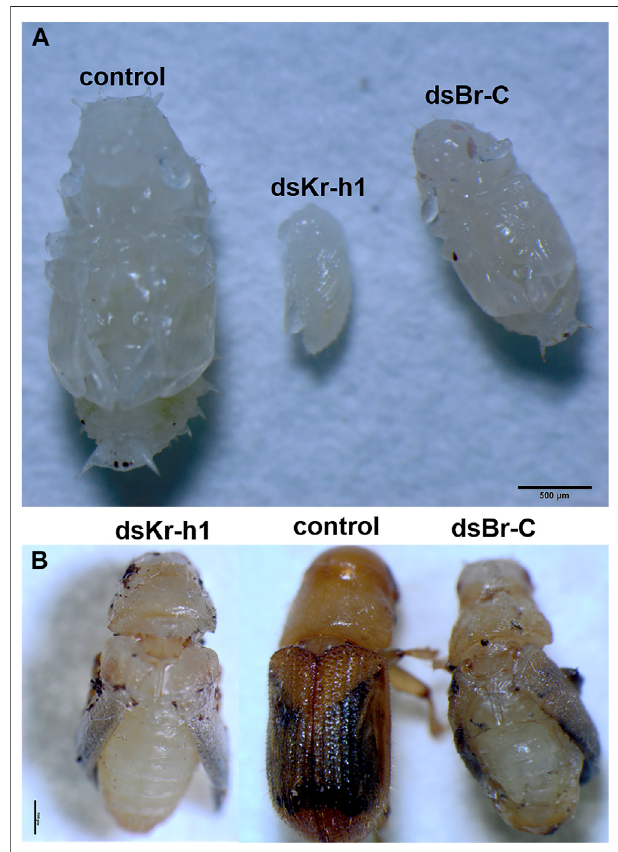
FIGURE 10 | Biological morphology of D. armandi . (A) The RNAi processing larva pupation pictures; (B) RNAi processing pupal emergence